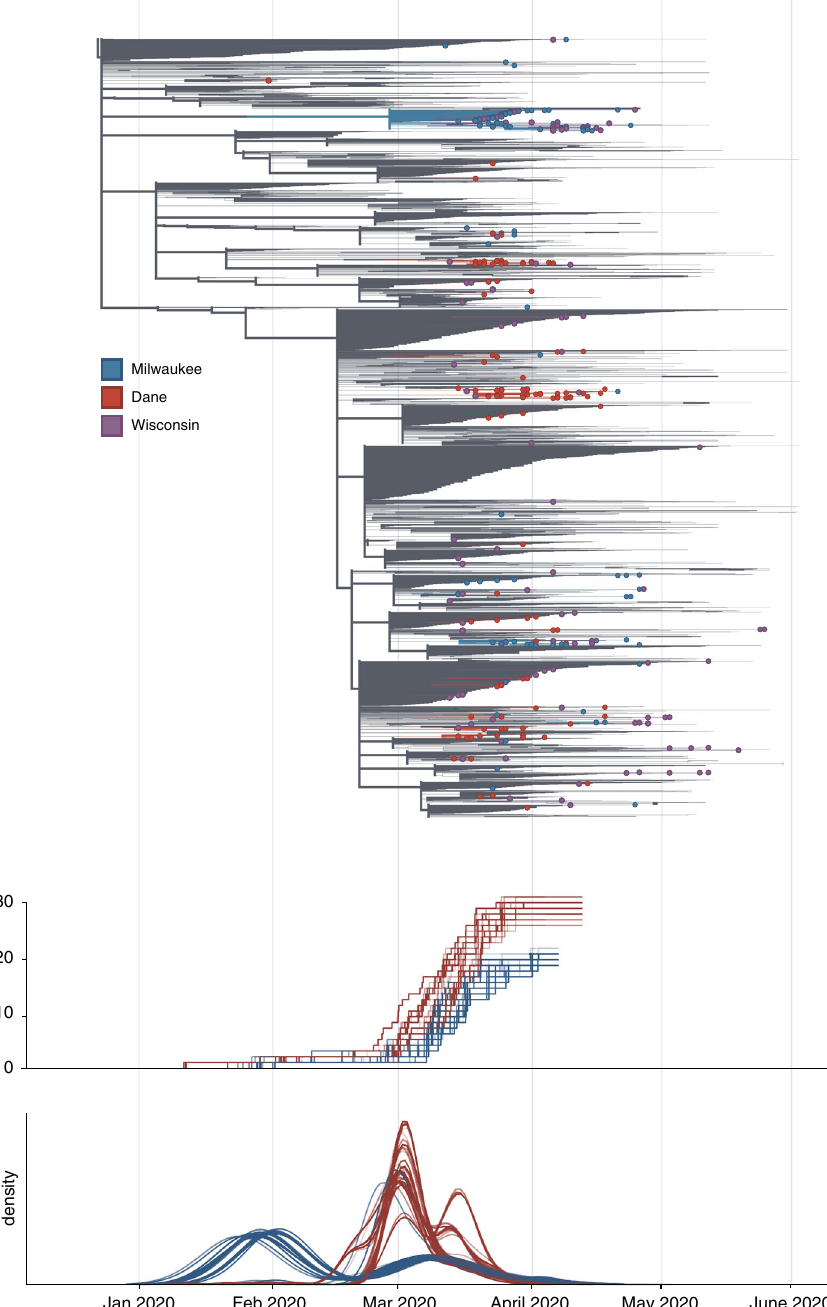
Fig. 4 Estimate of the number of introduction events into Milwaukee and Dane county and their relative contribution to downstream epidemic dynamics. a Maximum likelihood (ML) time-resolved tree, supported by 1000 bootstrap replicates, with subsampled global sequences and closest phylogenetic neighbors ’ relatives included (gray branches). Sequences from Dane and Milwaukee counties are highlighted in red and blue, respectively. Sequences with geolocation information available to the state level, or that are located outside of Dane and Milwaukee counties (i.e. La Crosse) are shown in purple. b Estimated cumulative number of introduction events into each county (derived using 100 bootstrap replicate trees). c Gaussian Kernel Density Estimate plots showing the estimated timing of each introduction event (three curves per replicate: mean and 90% con fi dence intervals) into Dane county (red) or Milwaukee county (blue). The relative number of samples from each region attributable to an introduction event is represented on the y axis. Curves are normalized to a cumulative density of one; therefore, y axis scale is not shown. Source data to replicate this fi gure can be found in the Source Data fi